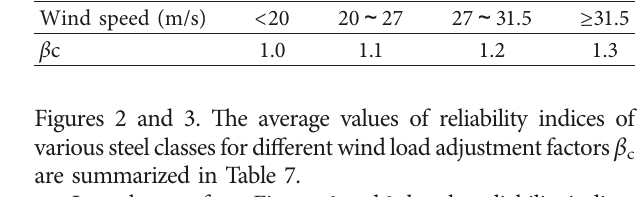
Table 5: Characteristic values and design values of steel strength. Table 6: Wind load adjustment coefficient β